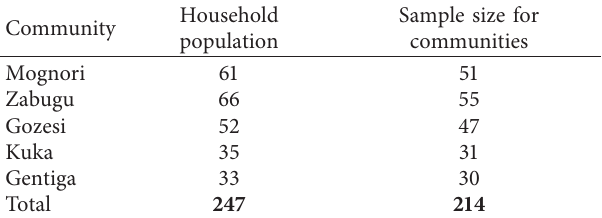
Table 1: Sample size of selected